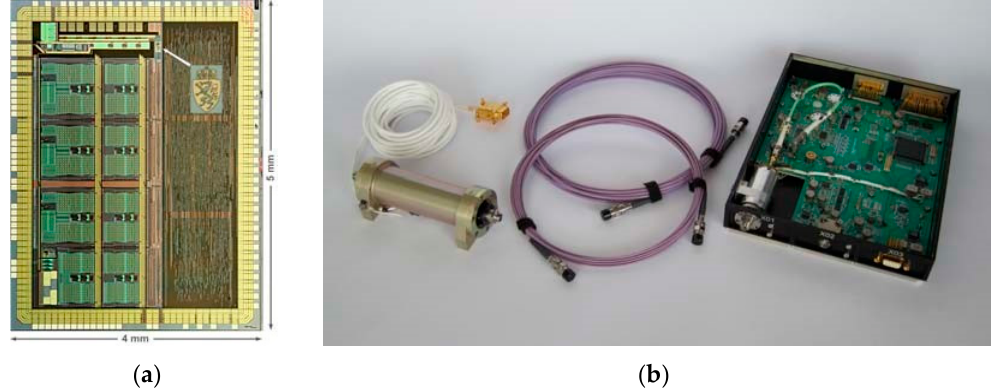
Figure 1. ( a ) Space qualified Applications Specific Integrated Circuit for the readout of the fluxgate magnetic field sensors onboard NASA’s Magnetospheric Multiscale Mission; ( b ) Flight model of the Coupled Dark State Magnetometer which was launched to its maiden flight on a Chinese rocket